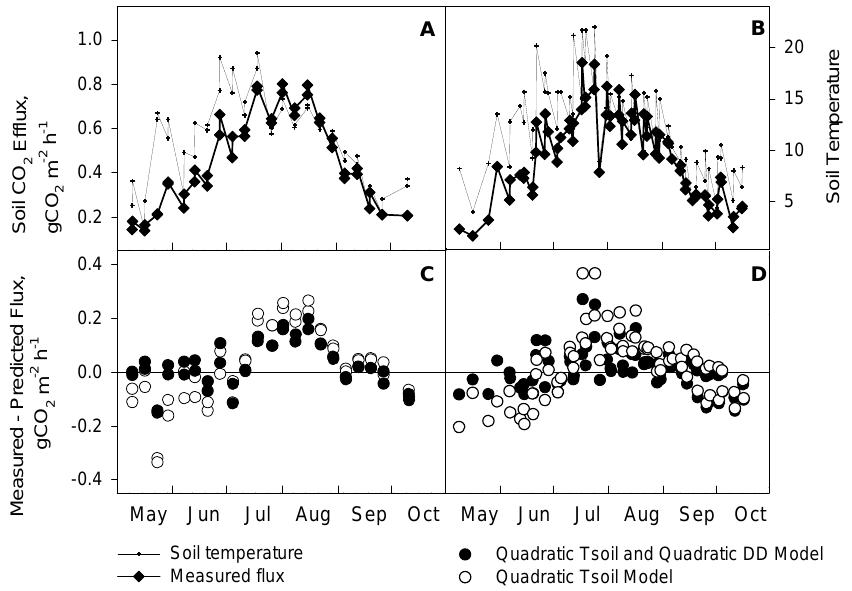
Fig. 6. Model evaluation: Soil CO 2 efflux and soil temperature at the time of measurements in 2000 ( (A) in Huhus and (B) in Mekrijärvi) and difference between measured and predicted efflux ( (C) in Huhus and (D) in Mekrijärvi). Models formulated as LnFlux = b 0 + b 1 × T soil + + b × degree_days + b × degree_days 2 . Note: Degree days (DD) = Cumulative sum b 2 × T 2 and LnFlux = b 0 + b 1 × T soil + b 2 × T 2 3 4 soil soil of daily air temperatures exceeding 5 ◦ C. See Table 2 for values of regression